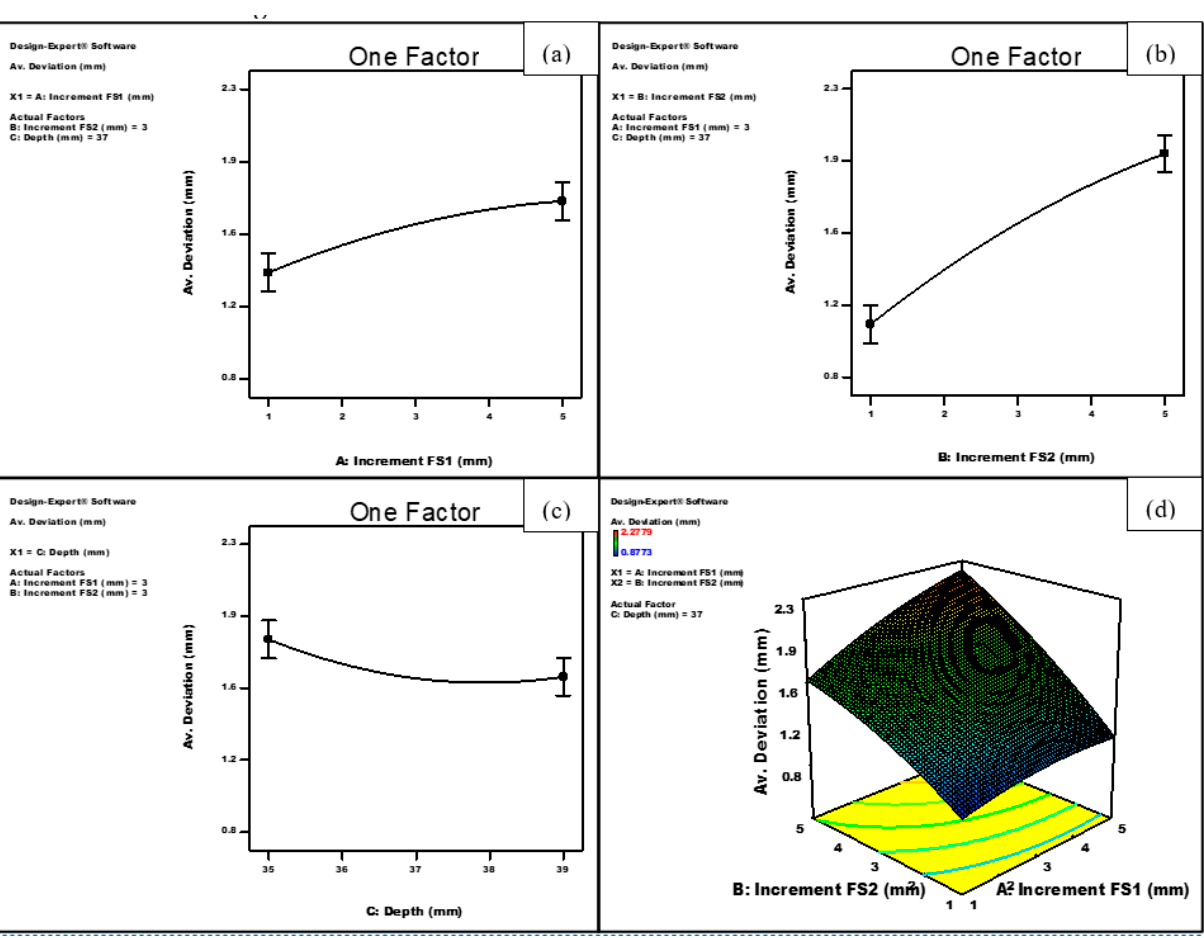
Figure 7. Effect of ( a ) increment of forming stage 1 (FS1), ( b ) increment of forming stage 2 (FS2), ( c ) depth of forming stage 1 and ( d ) the interaction between the increments of both forming stages on the average deviation.